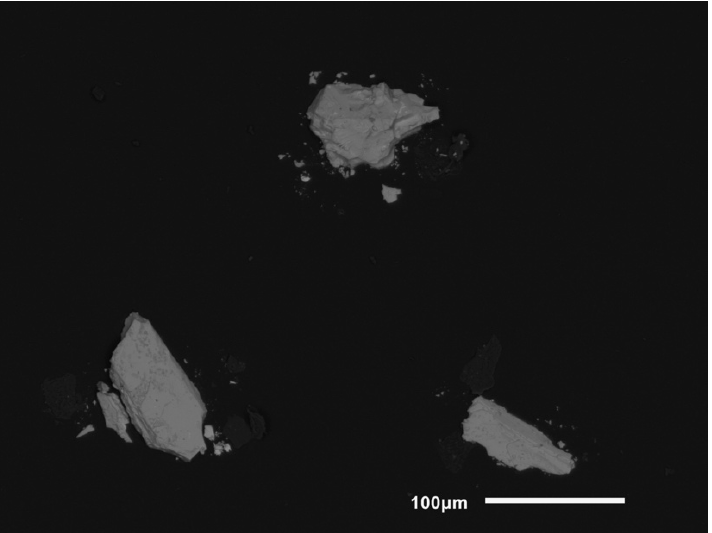
Figure 2. Crystals of HP-Sc 2 TeO 6 selected for elemental analysis by energy-dispersive X-ray spec- troscopy (EDX).